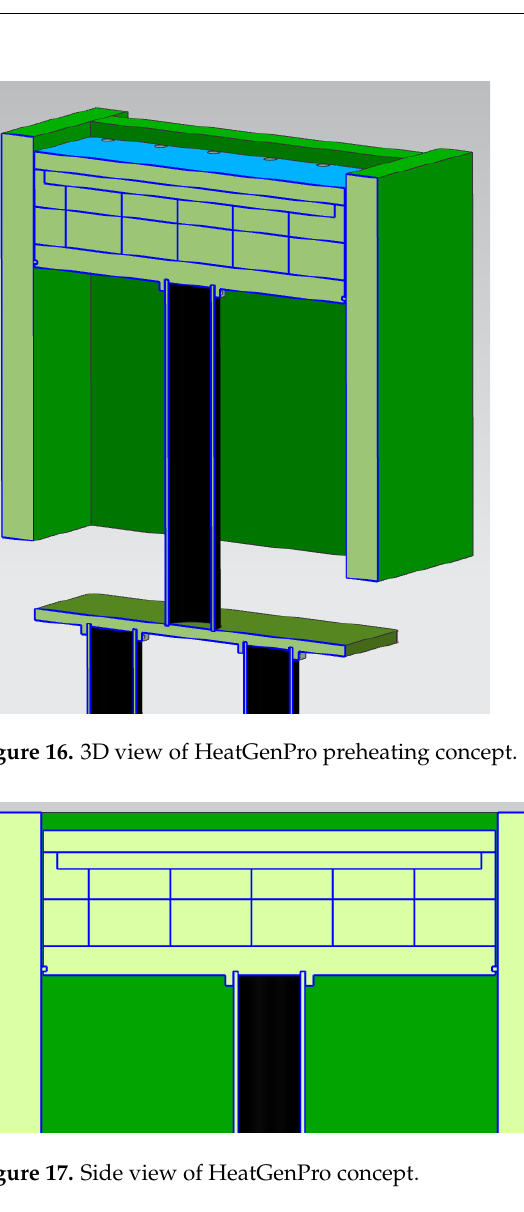
Figure 18. Front view of HeatGenPro concept.